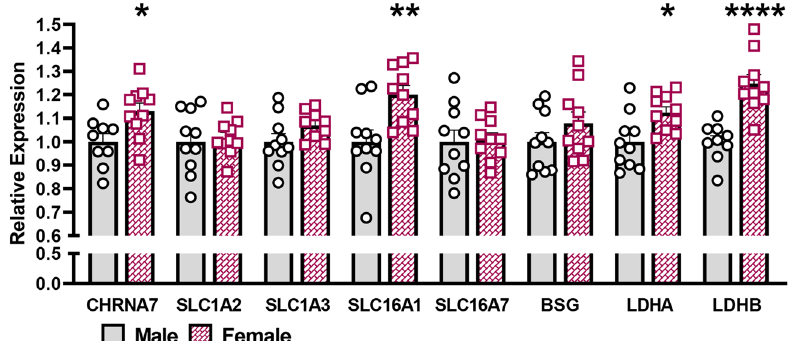
Figure 3. Hippocampal gene expression. Relative hippocampal mRNA expression levels of genes involved in the ANLS from male (gray) and female (purple) C57BL/6J mice. *p < 0.05, **p < 0.01, ****p < 0.0001; n =